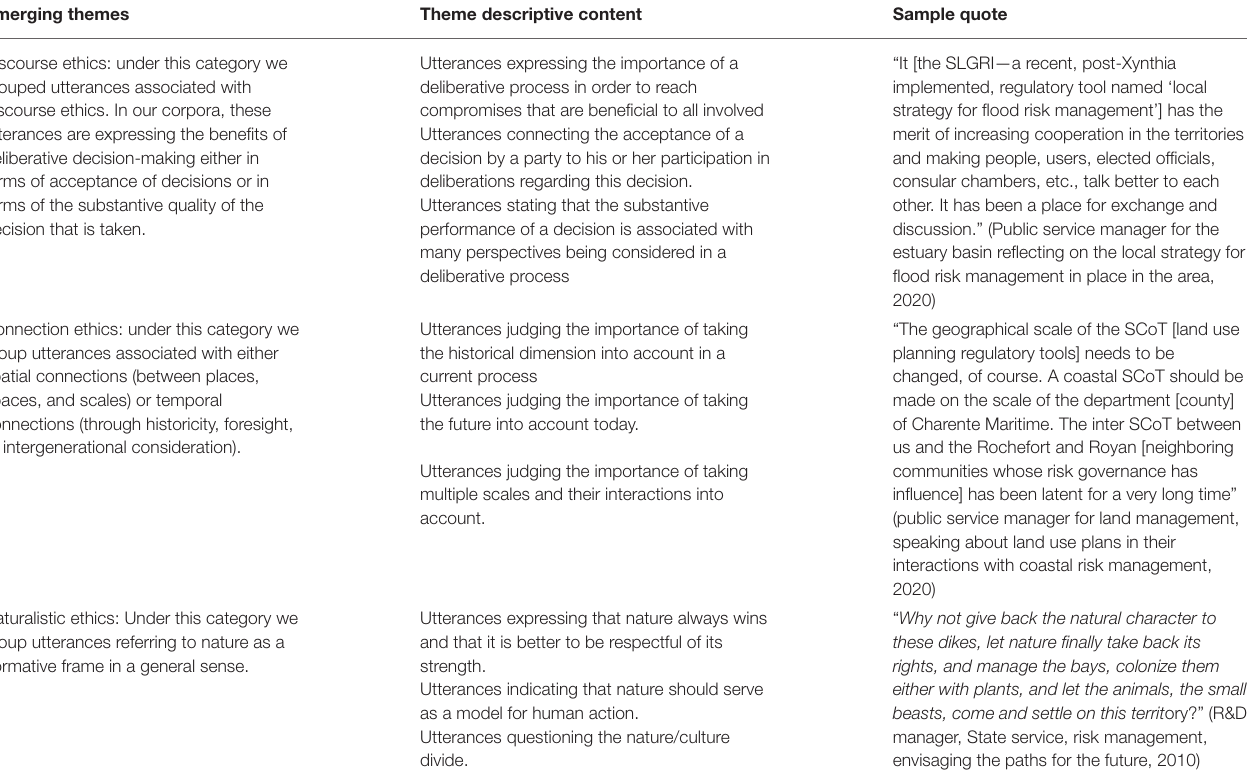
TABLE 3 | Emerging thematic coding